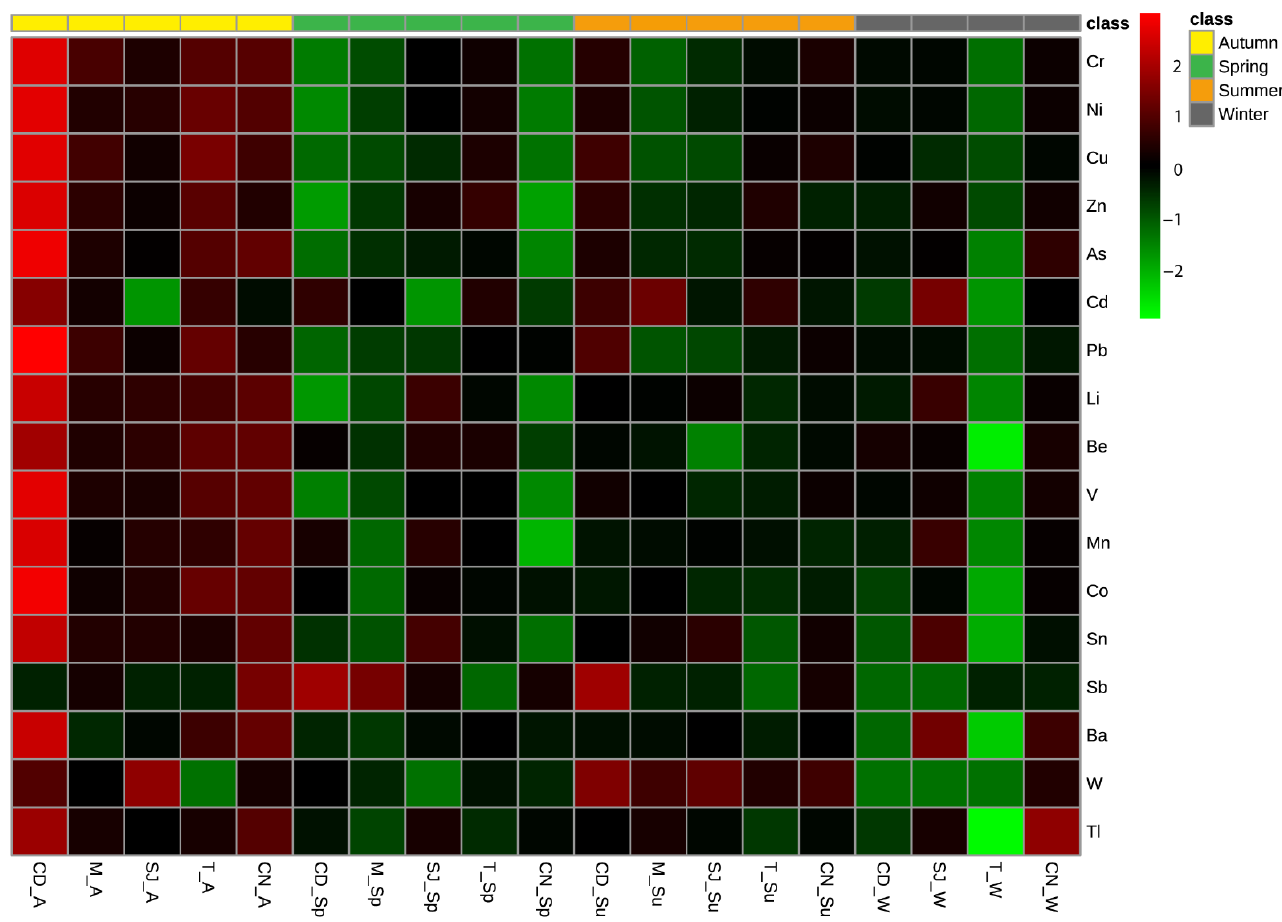
Figure 1. Heatmap comparing major element concentrations (Al, Ca, Fe, K, Mg, Na, and P) in sedi- ments from sampling sites. CD, M, SJ, T, and CN represent the sites Cale do Ouro, Murtosa, São Jacinto, Torreira, and Costa Nova, respectively. A, W, Sp, and Su represent the seasons of the year: autumn, winter, spring, and summer.